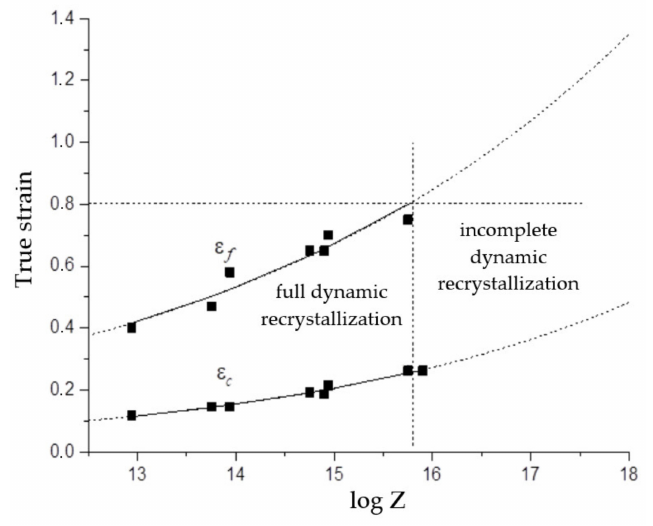
Figure 6. Critical strains ε c and ε f us function of the Zener–Holloman